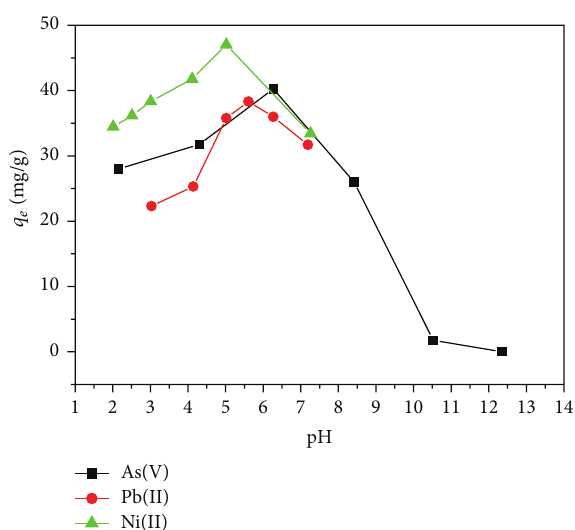
Figure 7: Influence of pH on the adsorption of As(V), Pb(II), and